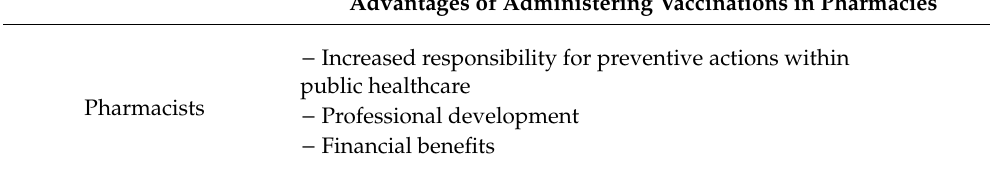
Table 2. Advantages of administering vaccinations in pharmacies for patients, medical sta ff and the healthcare